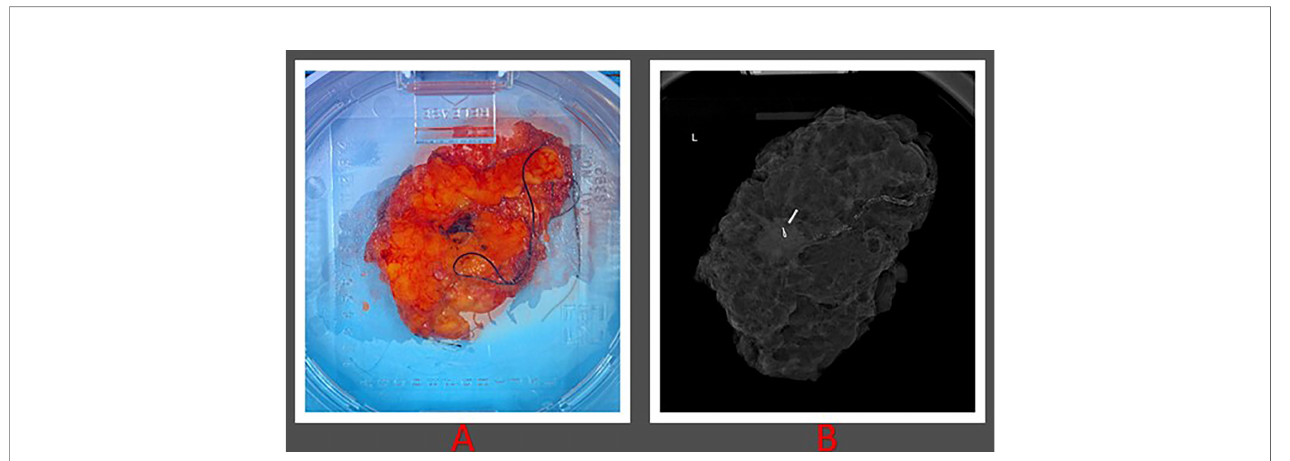
FIGURE 2 | Histopathological images of patient 1. (A) Gross lumpectomy specimen measuring 10 cm in dimension extending from superior to inferior margin and measuring 6.2 cm extending from lateral to medial margin. (B) Lumpectomy specimen with presence of radiological